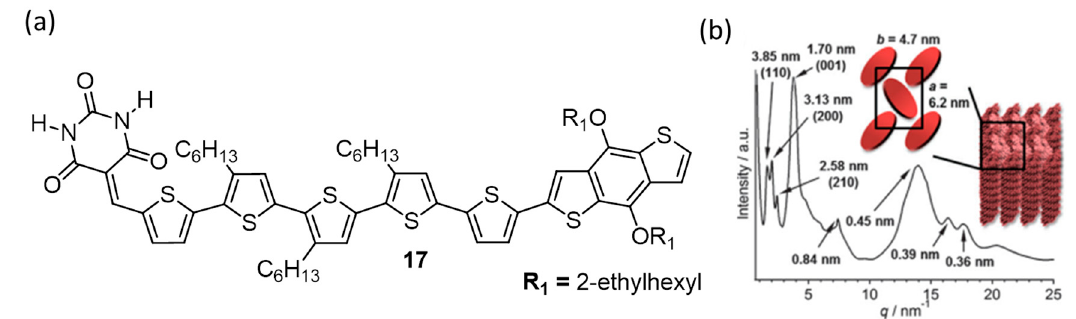
Figure 7. ( a ) Chemical structure of 17 synthesized by Yagai et al. [54]. ( b ) PXRD patterns of bulk samples of 17 /PC 61 BM at 25 °C. Adapted with permission from Ref. [54] Copyright 2016 The Royal Society of Chemistry.